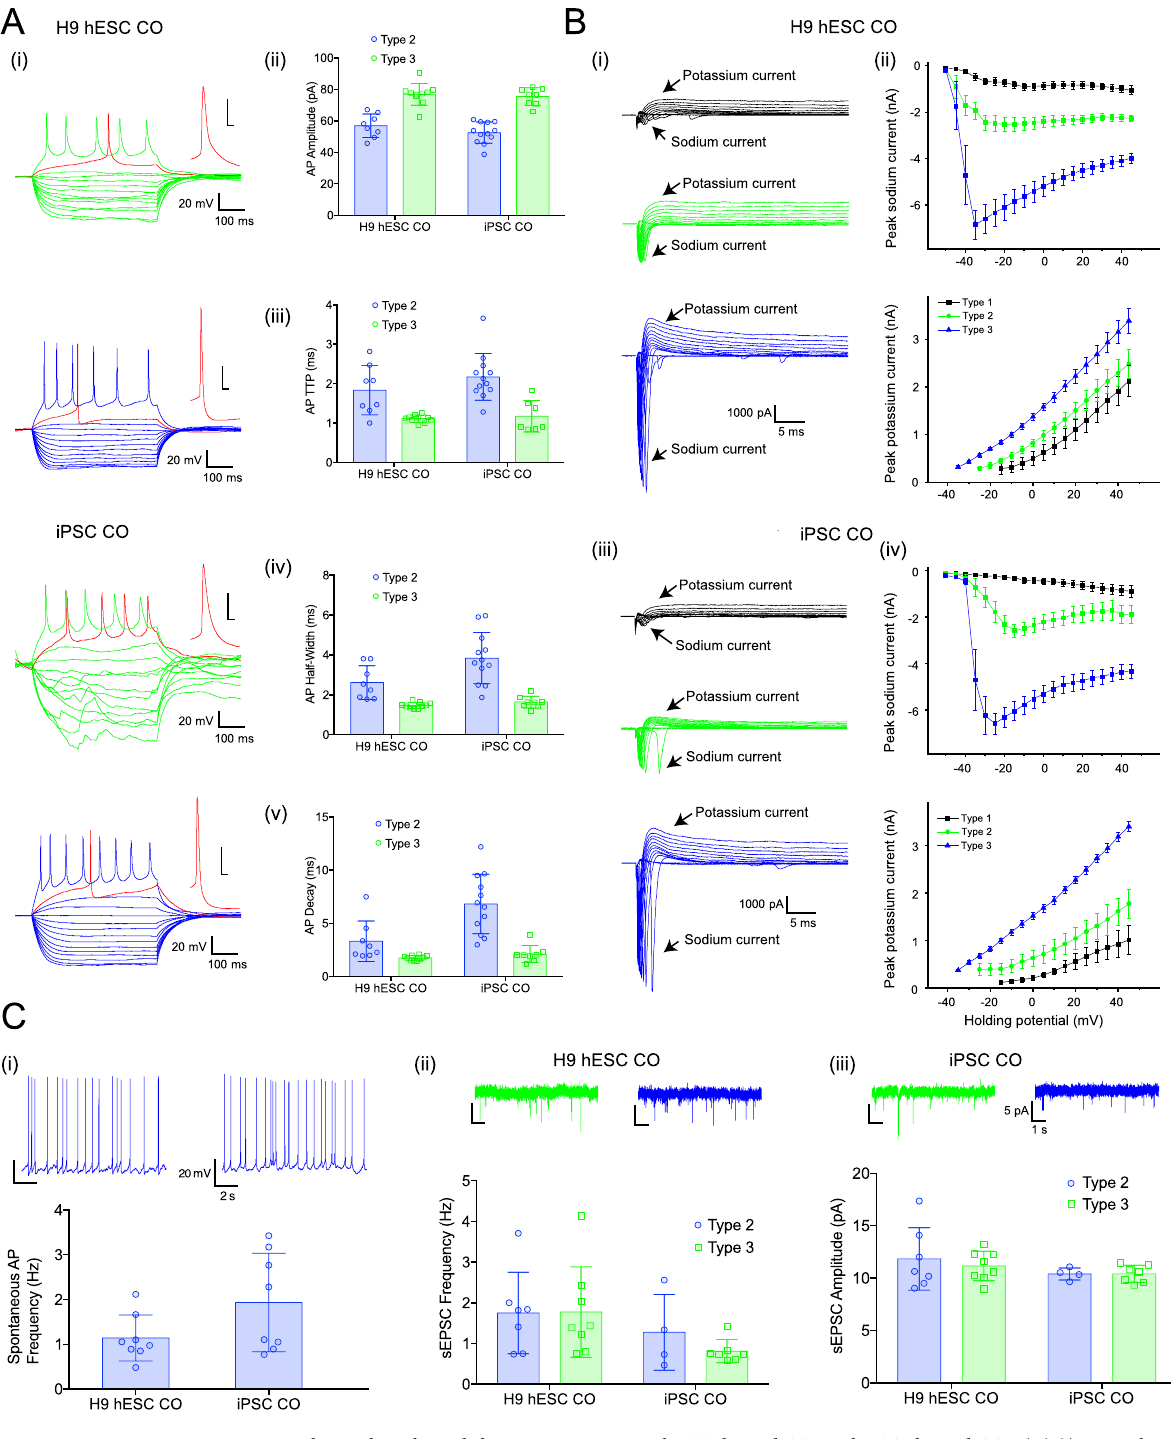
Figure 5. Electrophysiological characterization in H9 hESC-derived COs and iPSC-derived COs. ( A ) (i) Examples of voltage responses to hyperpolarizing and depolarizing set of currents recorded from type 2 (green) and type 3 (blue) neurons. Individual APs are expanded in the insert (red), scale 20 mV/5 ms. Summary bar graphs showing (ii) AP amplitudes, (iii) rise time, (iv) half-width and (v) decay, note that APs have lower amplitude and slower kinetic in type 2 neurons. ( B ) (i) Examples of inward sodium and outward potassium currents recorded from neurons type 1 (black), type 2 (green) and type 3 (blue). Scale bar is the same for all traces. Summary current–voltage plots showing increase in peak current amplitude for both sodium (top) and potassium (bottom) during neuronal maturation (ii and iii). These plots look similar independently of COs origin. ( C ) (i) Examples of spontaneous AP firing in type 3 neurons (top) and summary bar graph of AP frequency in H9 hESC- and iPSC-derived COs (bottom). (ii) Examples of spontaneous excitatory postsynaptic currents (EPSCs) recorded from type 2 (green) and type 3 (blue) neurons. Scale bar is the same for all traces. (iii) Summary bar graphs showing that spontaneous synaptic activity including sEPSC frequency (left) and amplitude (right) was similar in both types of neurons regardless origin of COs. Error bars show standard